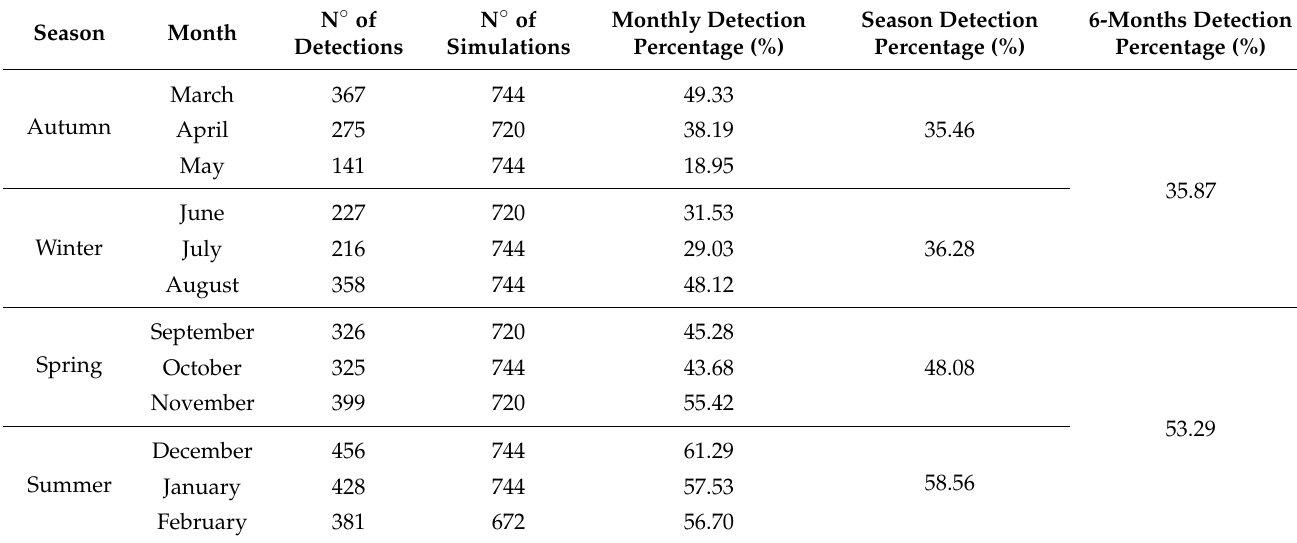
Table 4. Quantitative results of thermal gradient observations above the threshold recommended by ASTM D4788-03. N ◦ of N ◦ of Monthly Detection Season Detection 6-Months Detection Season Month Detections Simulations Percentage (%) Percentage (%) Percentage